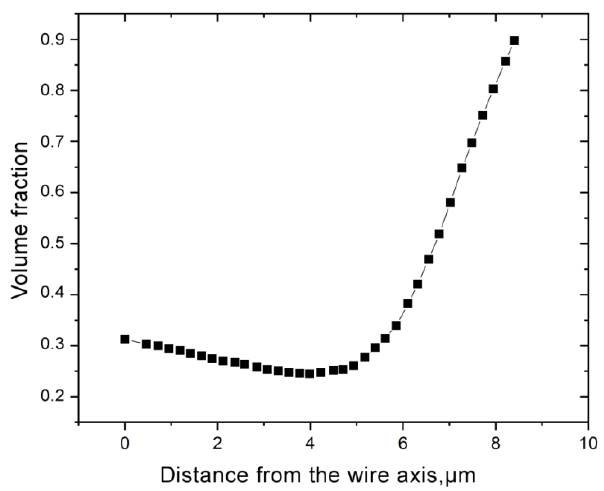
Figure 6. Volume fraction of the nanocrystalline phase depending on the microwire axis.